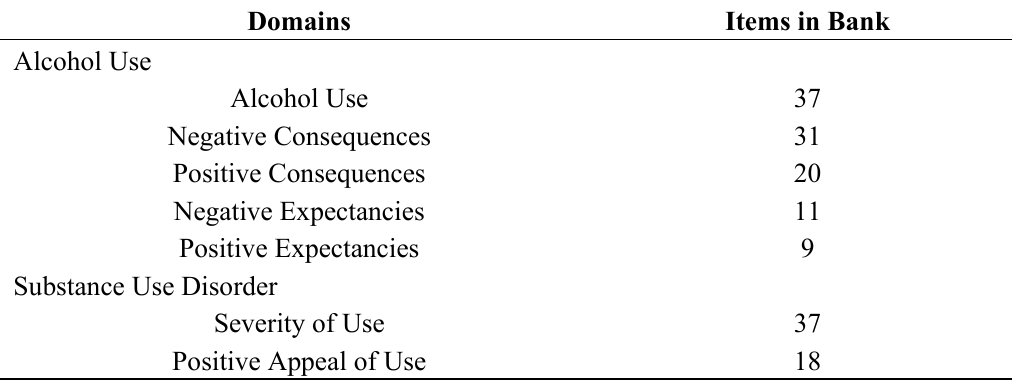
Table 3. * PROMIS Alcohol and Substance Use Disorder